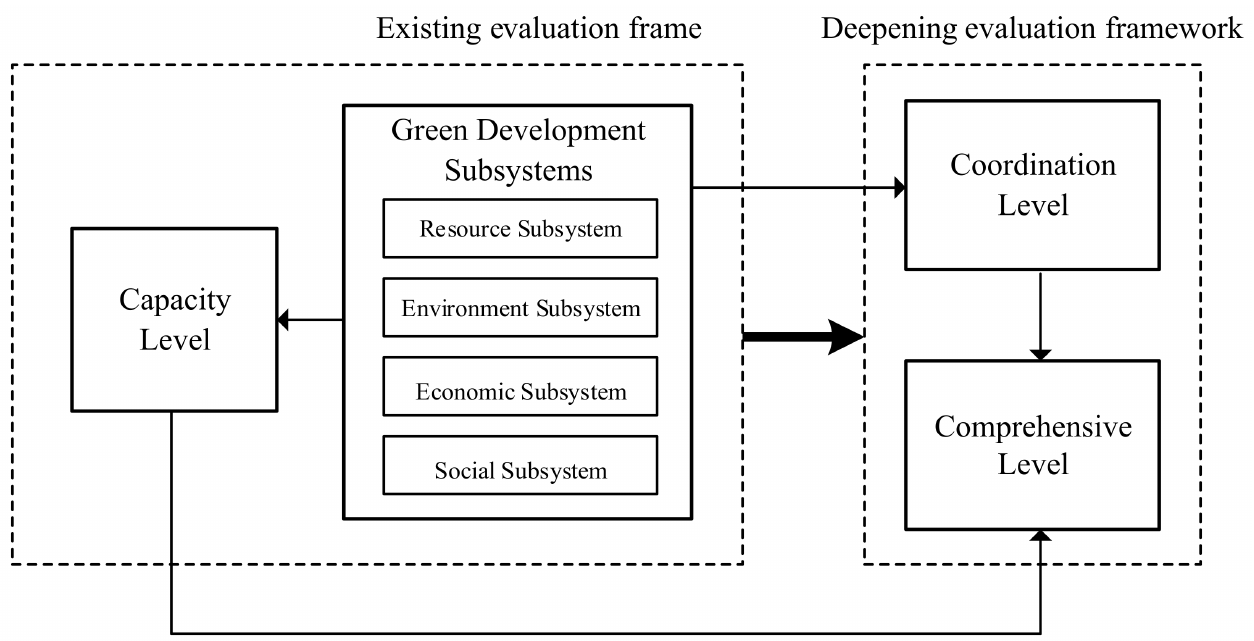
Figure 2. The green development evaluation framework adopted in this